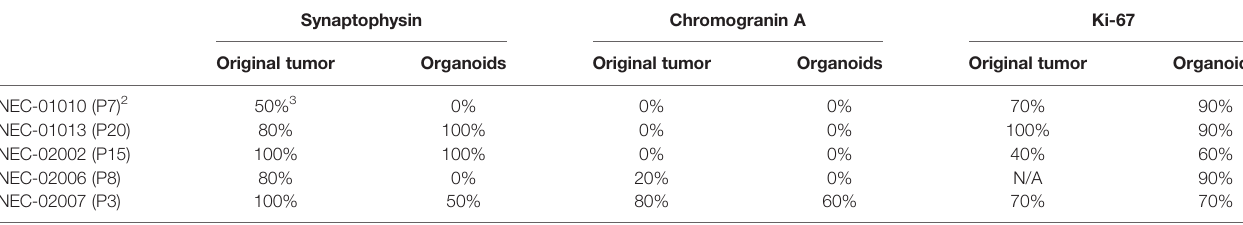
TABLE 1 | Expression of Ki-67 and neuroendocrine markers in original tumor and organoids 1 .